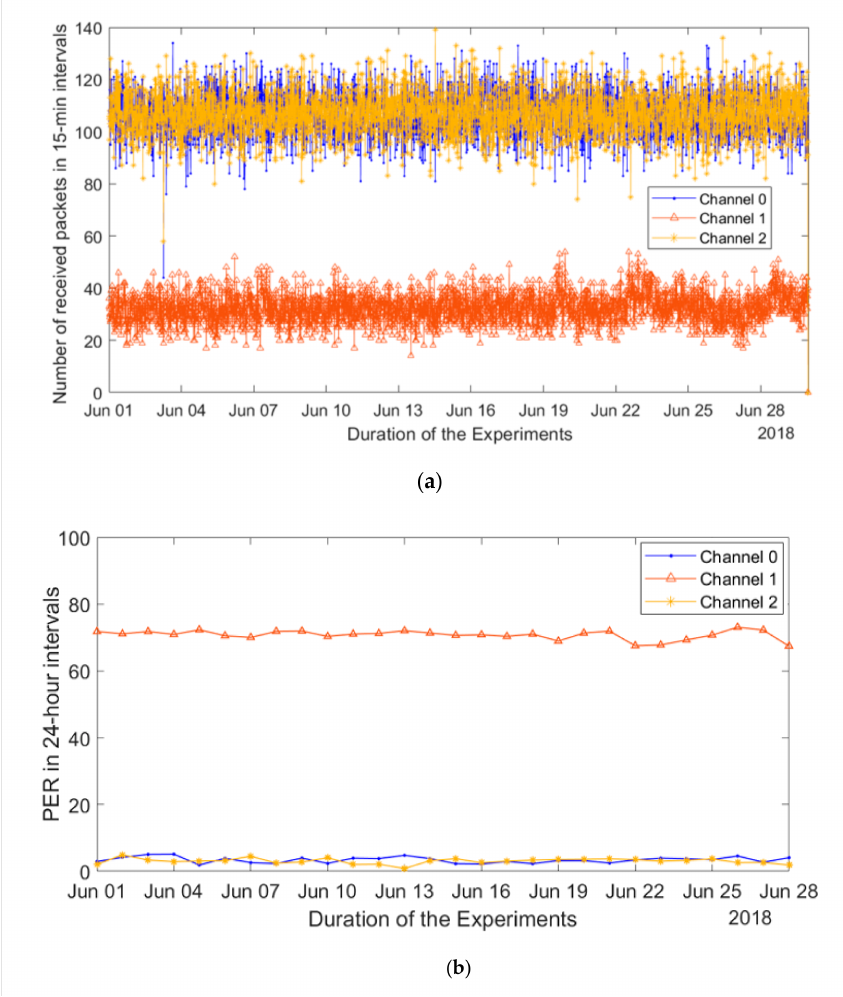
Figure 8. Analysis of the e ff ect of frequency channel on packet error rate (PER). ( a ) Distribution of the received packets between the frequency channels for a month (June 2018). ( b ) Average PER for each channel through that month PER on di ff erent days for weekend and